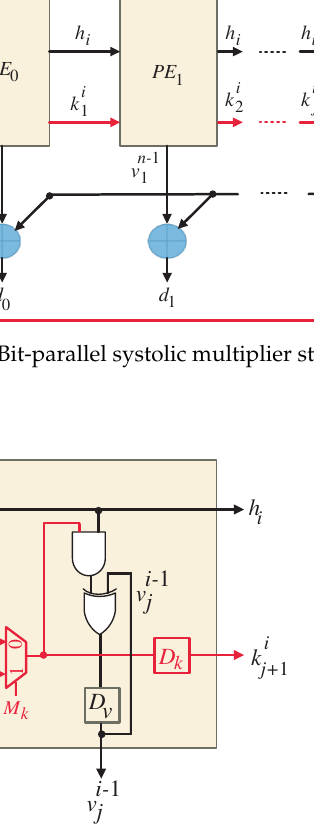
Figure 4. Logic diagram of PE j . D k symbolizes a